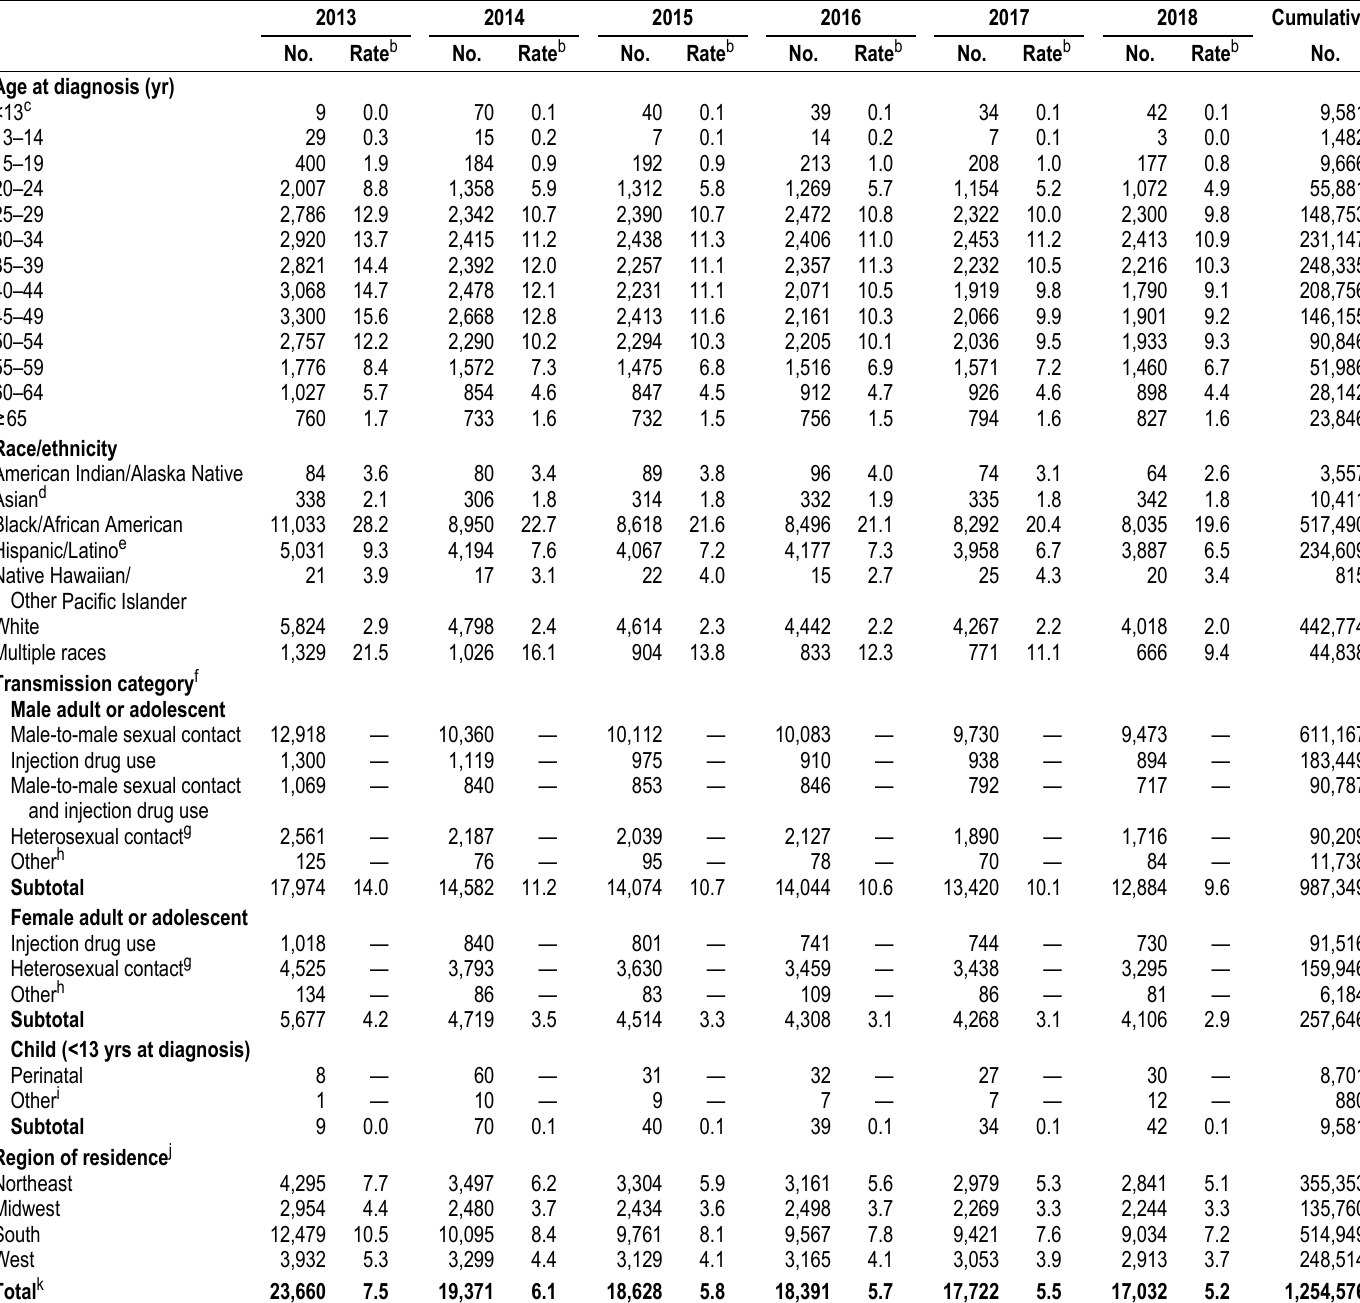
Table 2a. Stage 3 (AIDS), by year of diagnosis and selected characteristics, 2013–2018 and cumulative—United